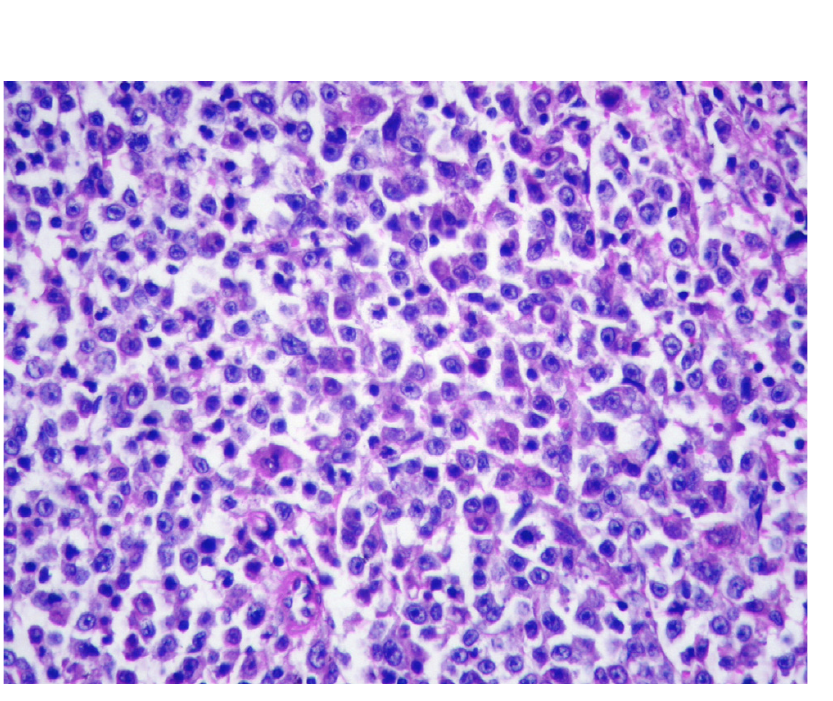
Figure 4 Morphology of Splenic marginal zone lymphoma. Small lymphocytes, marginal zone cells and cells resembling monocytoid cells (H&E, original magnification